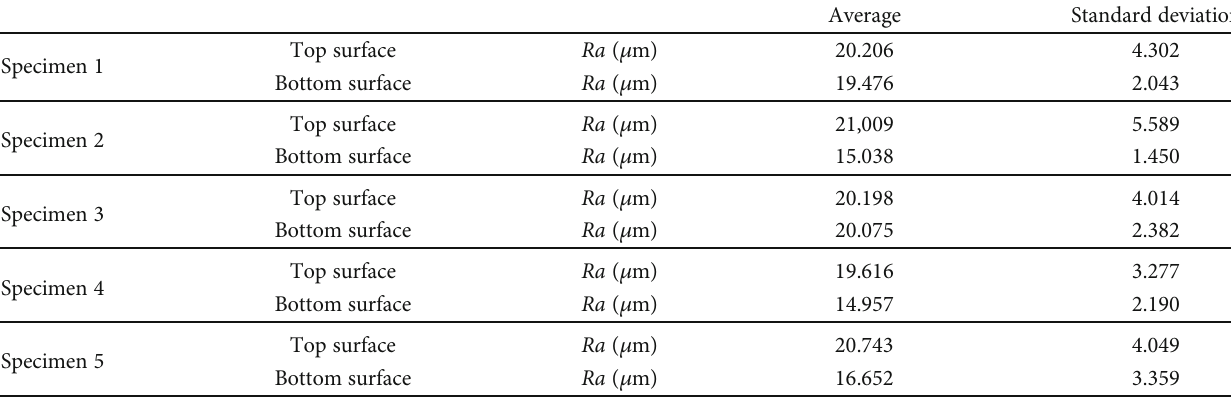
Table 8: Surface roughness of built test